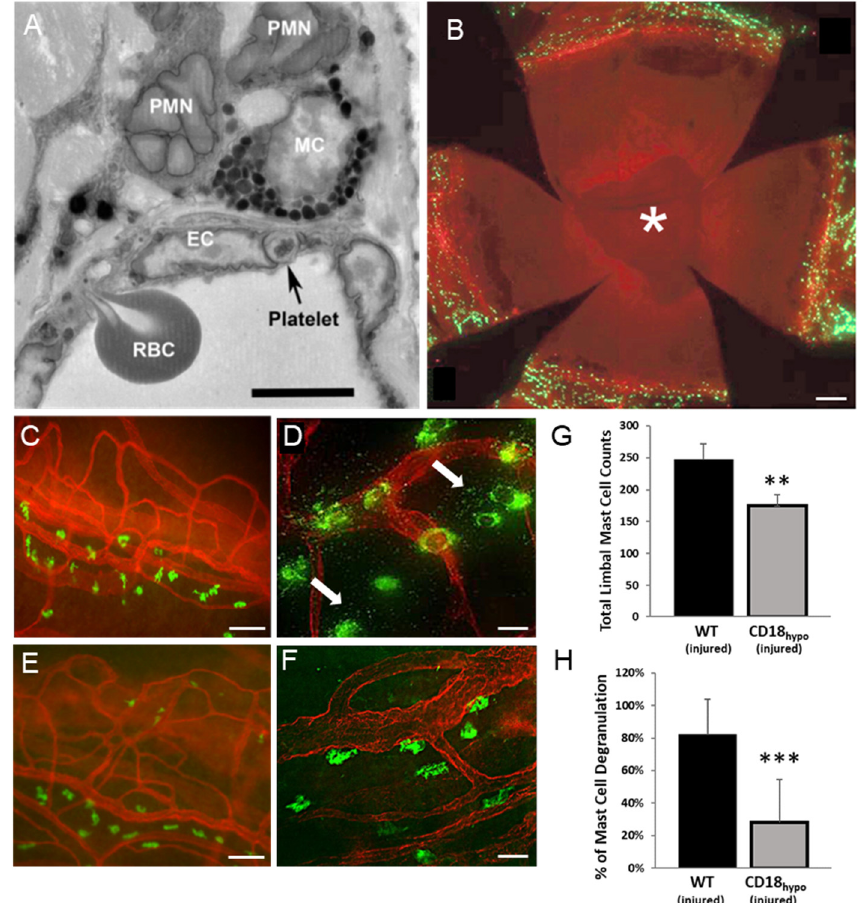
Figure 3. Reduced mast cell degranulation after corneal abrasion in CD18 hypo mice. ( A ) Electron micrograph of a WT mouse cornea 8 h after epithelial abrasion showing a platelet and an RBC in the process of traversing the inflamed endothelium of a limbal venule. Extravascular PMNs are in contact with a perivascular mast cell (MC). ( B ) Representative whole-mount image of a WT mouse cornea at 18 h after epithelial abrasion. Note the open wound (*). Perivascular mast cells (green, FITC-avidin) were detected at the limbus and not in the avascular cornea. ( C – F ) Immunofluorescence images of flat-mounted corneas where mast cells (FITC-avidin, green) are positioned next to the limbal venules (anti-CD31, red). ( C ) Uninjured WT cornea. ( D ) Twenty-four hours after an abrasion, mast cell degranulation (arrows) is apparent in the WT mouse. ( E ) Uninjured CD18 hypo cornea. ( F ) Twenty-four hours after an abrasion, mast cell degranulation is not evident (compare with WT image ( D )). ( G ) Data showing limbal mast cell counts and ( H ) the percentage of mast cells undergoing degranulation ( n = 6 per group, ** p ≤ 0.01 and *** p ≤ 0.001). Bar = 5 µm ( B ); Bars = 60 µm ( C , E ); Bars = 15 µm ( D , F ).